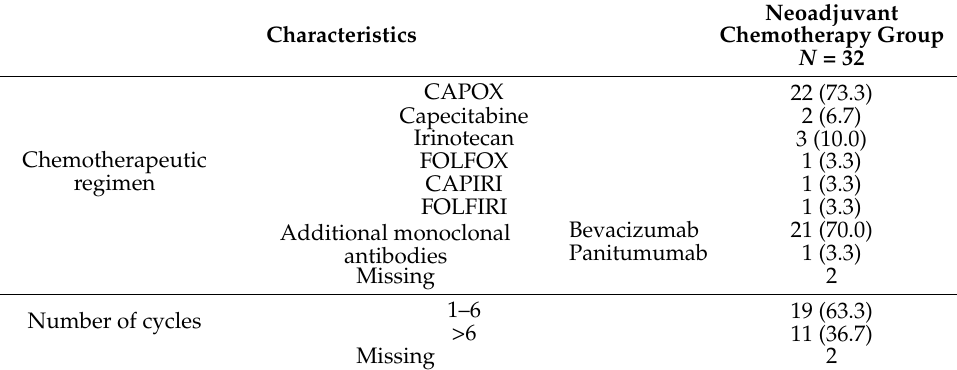
Table 4. Chemotherapeutic characteristics per